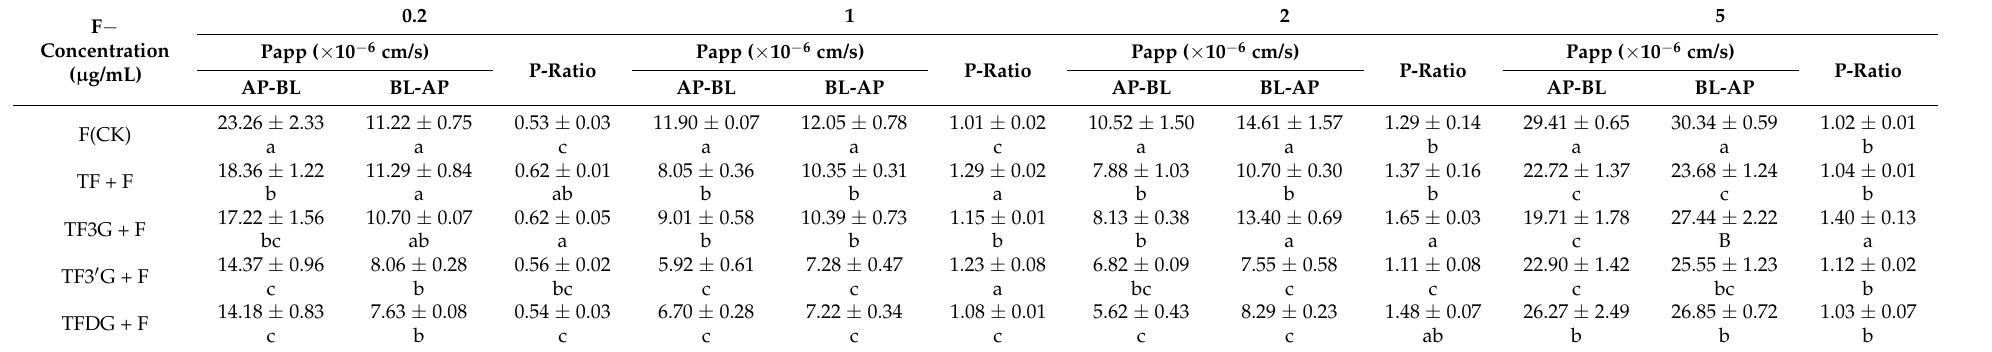
Table 3. Effects of different concentrations of F − on the apparent permeability coefficient of F − transport in Caco-2